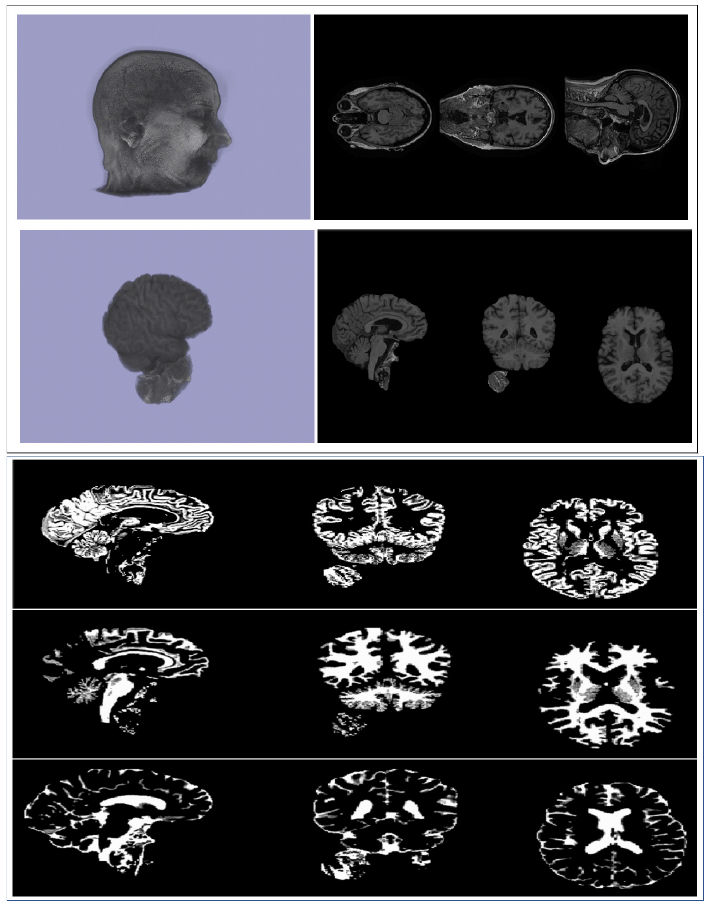
Figure 1. ( Top row ) An original MRI image and the corresponding axial views. ( Second row ) Brain image extracted using BET tool and its axial views. ( Bottom three rows ) Segmentation of the extracted brain image using FAST; from top to bottom: gray matter (GM), white matter (WM), and cerebrospinal fluid (CSF) images,